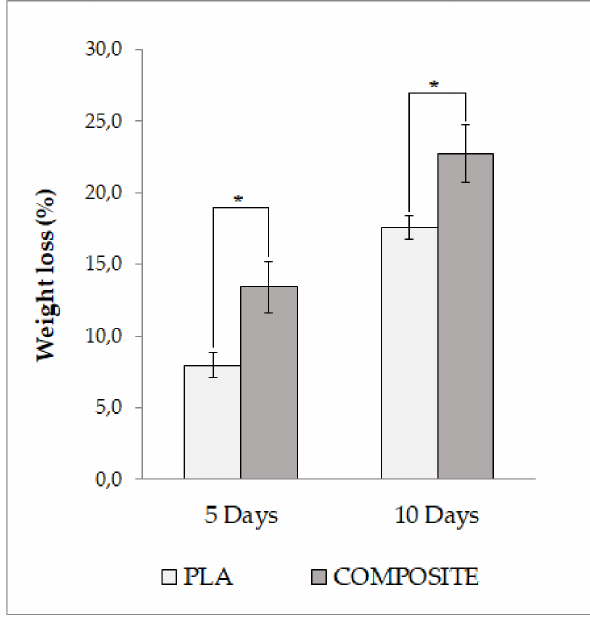
Figure 1: Weight loss percentage of 3D printed scaffolds at the time periods